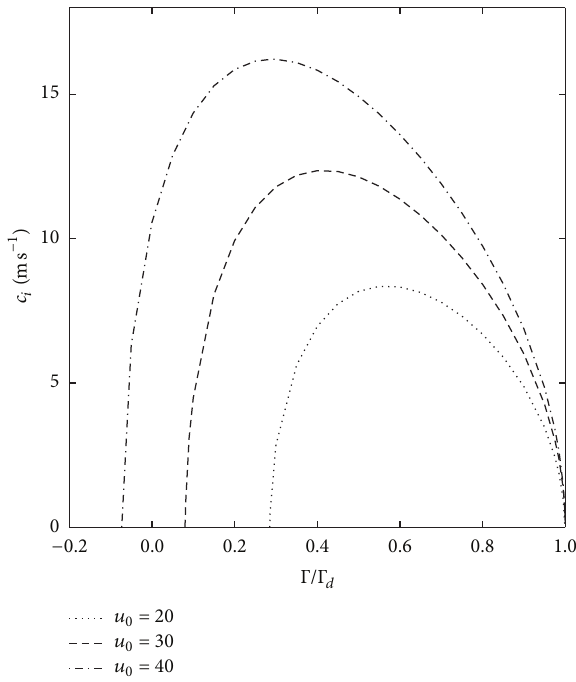
Figure 7: Imaginary part of phase speed 𝑐 𝑖 versus dimensionless temperature lapse rate Γ/Γ 𝑑 for different values of vertically averaged zonal wind velocity 𝑢 0